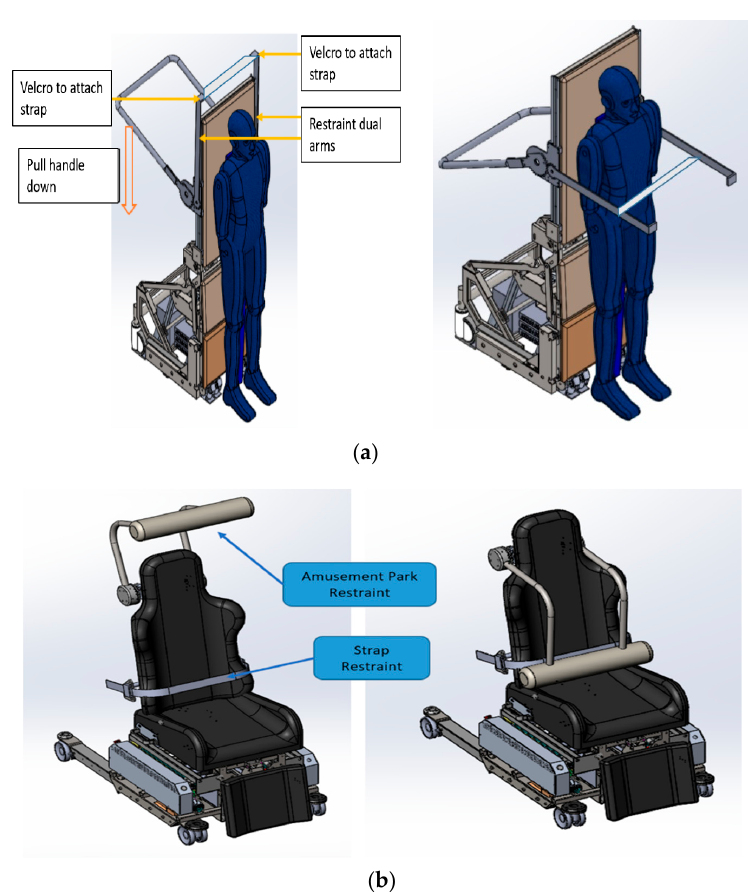
Figure 6. Restraint module of IMOVE systems. ( a ) Restraint arms in standby ready position and deployed position in IMOVE 1. ( b ) Restraint arms in standby ready position and deployed